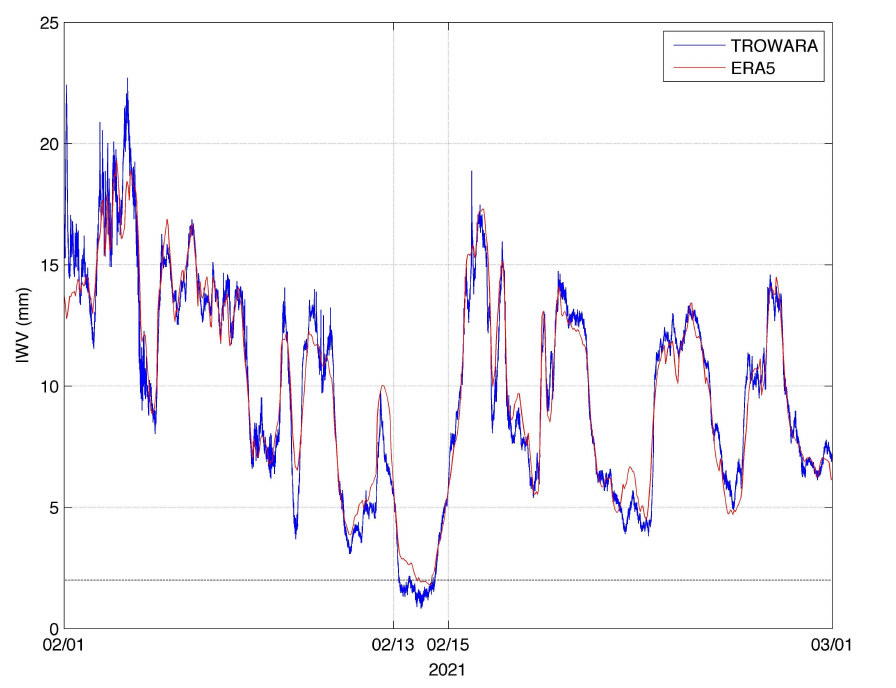
Figure 2. IWV above Bern during February 2021 as observed by TROWARA (blue) and estimated by ERA5 (red). The horizontal black line is for IWV = 2